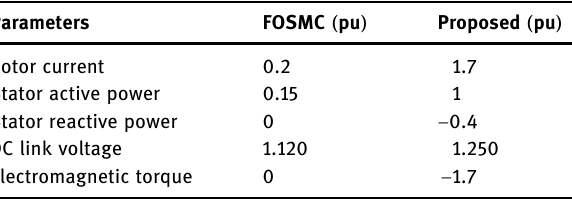
Table 6: Comparison of the proposed controller with FOSMC Parameters